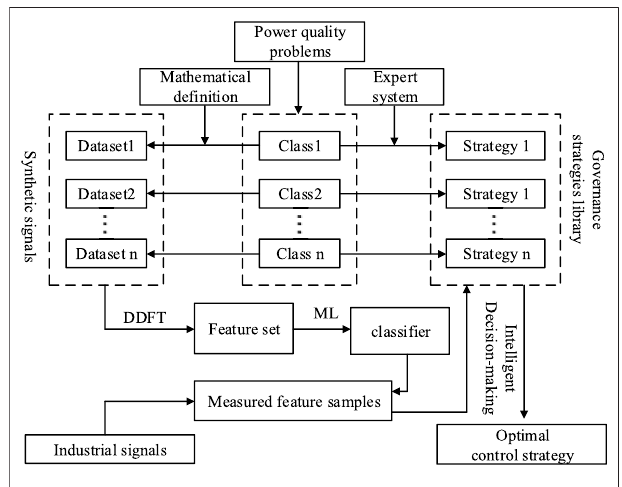
FIGURE 1 | The framework of intelligent governance